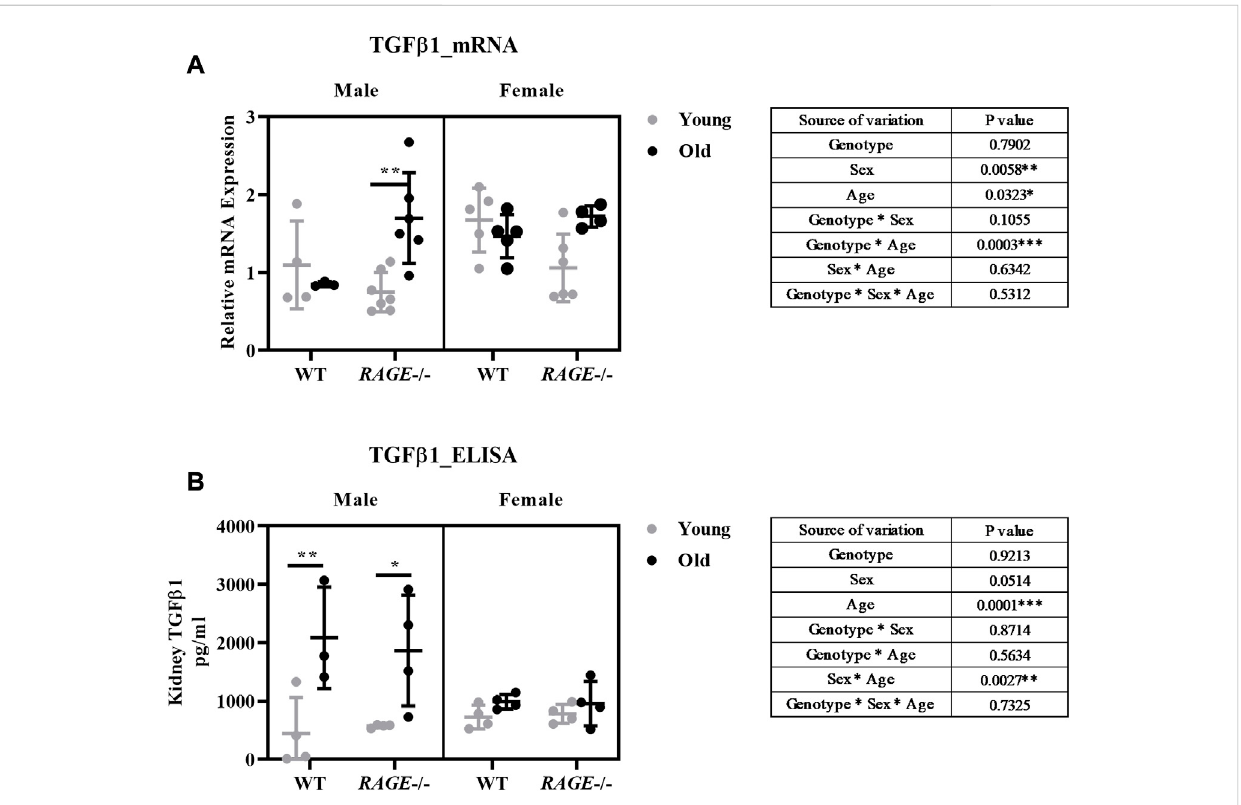
FIGURE 6 Expression analysis of TGF- β 1 at the mRNA and protein level: (A) mRNA quanti fi cation by q-PCR for TGF- β 1 markers from the renal cortex. (B) Quanti fi cation of TGF- β 1 protein concentrations in kidney tissue homogenates by ELISA. Signi fi cance and interaction were calculated by three-way ANOVA with genotype (wild type vs. RAGE − / − , sex (male vs. female), and age (young vs. old) as three factors (shown in table insert). Sidak multiple comparisons tests were performed for intergroup signi fi cance (shown above bars). Young ( < 30 weeks) and old ( > 70 weeks) male and female mice ( n = 3 – 7) were used in the experiment. Data are shown as mean ± SD; p- value: 0.05*, 0.01**, 0.001***, and